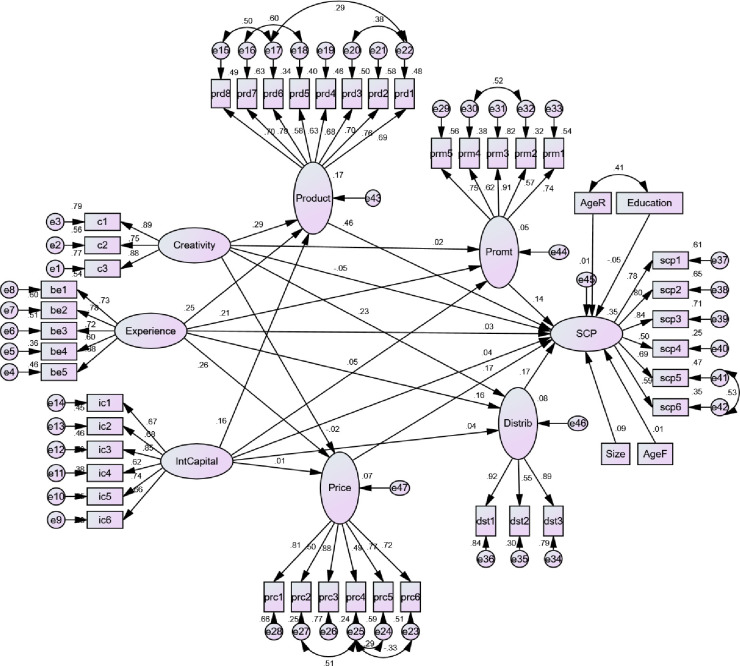
Structural model.